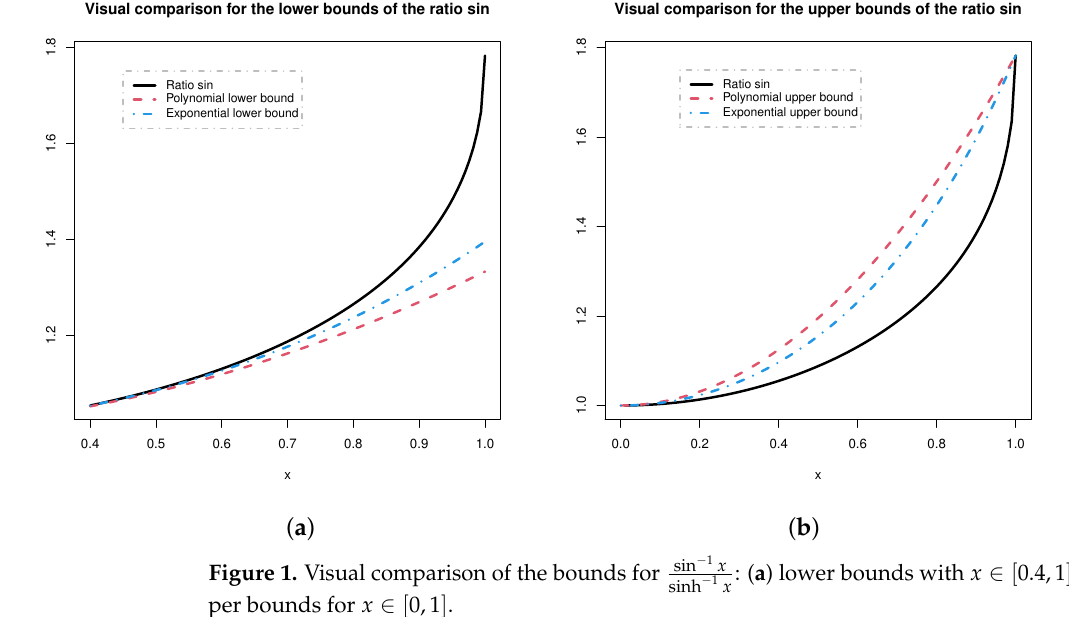
: ( a ) lower bounds with x ∈ [ 0.4,1 ] , and ( b ) up- sinh − 1 x